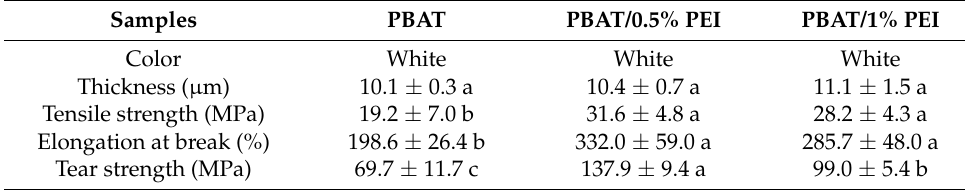
Table 3. Mechanical properties of PBAT and PBAT/PEI